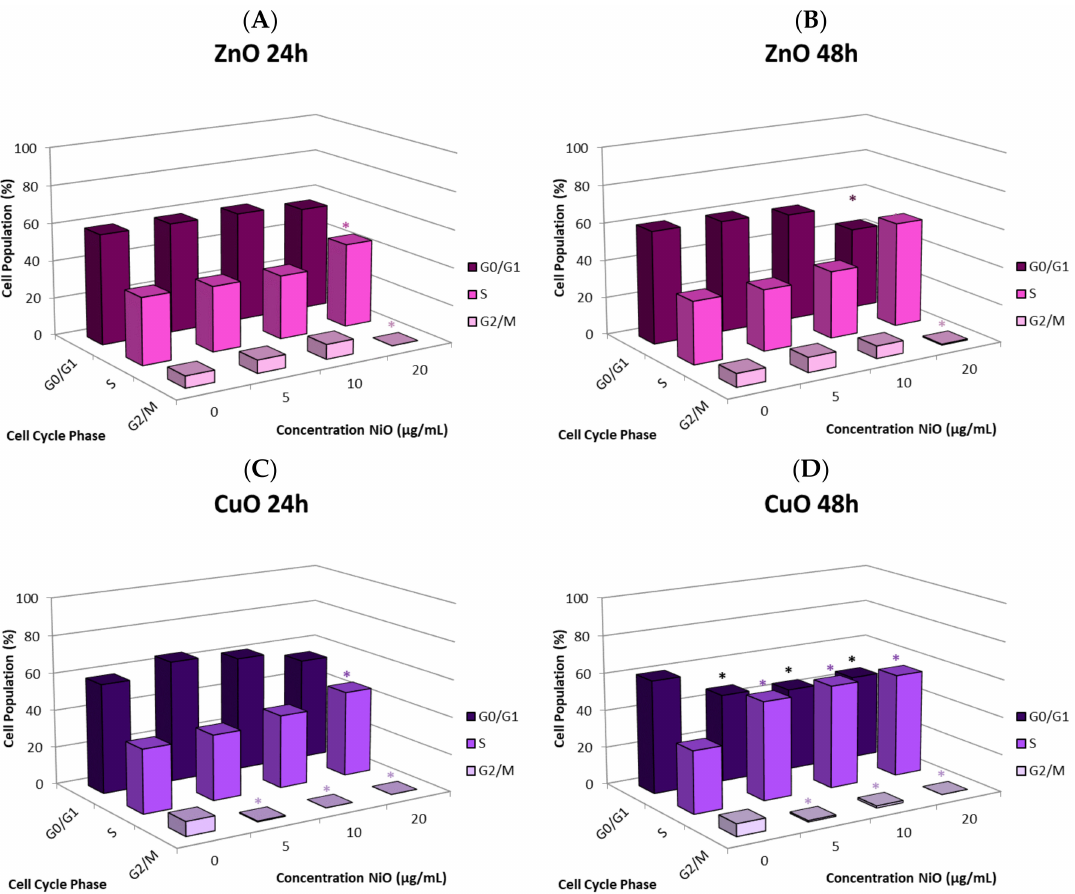
Figure 5. Alteration of cell cycle of A549 cells after exposure to various concentrations of ZnO NPs for ( A ) 24 h and ( B ) 48 h or CuO NPs for ( C ) 24 h or ( D ) 48 h. Values significantly di ff erent from the control ( p ’s < 0.05) are indicated with